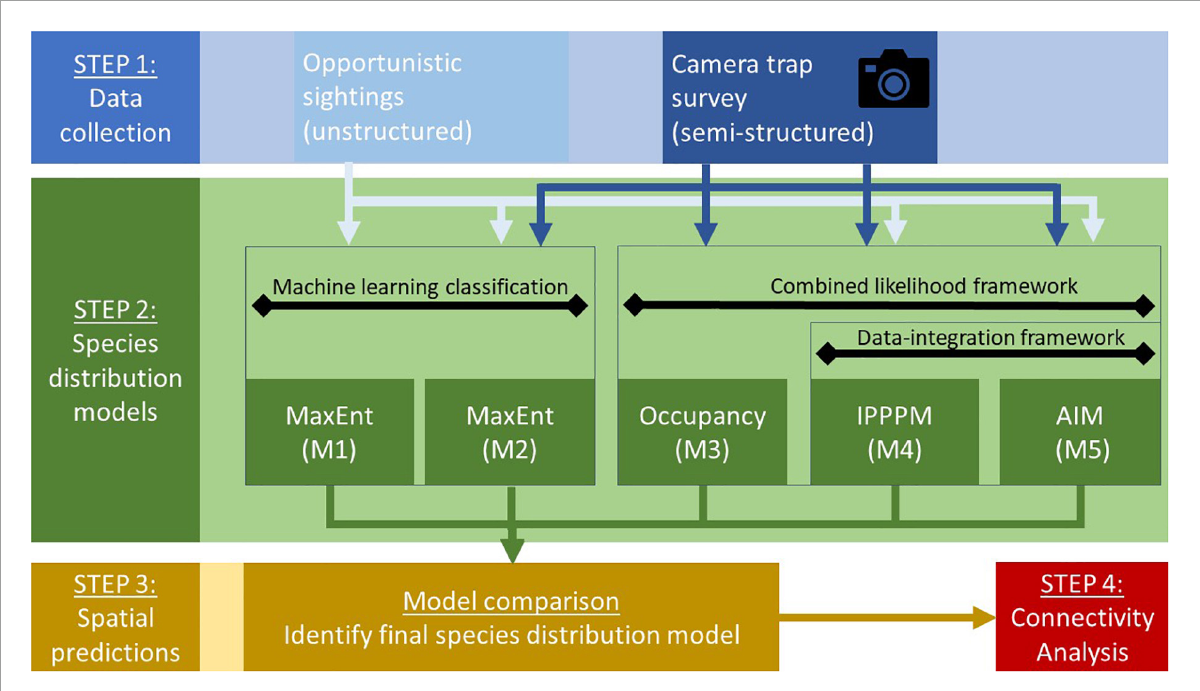
FIGURE2 General workflow for generating species distribution models with different data input. *IPPPM: Inhomogeneous point process model (reference model); **AIM: Area interaction